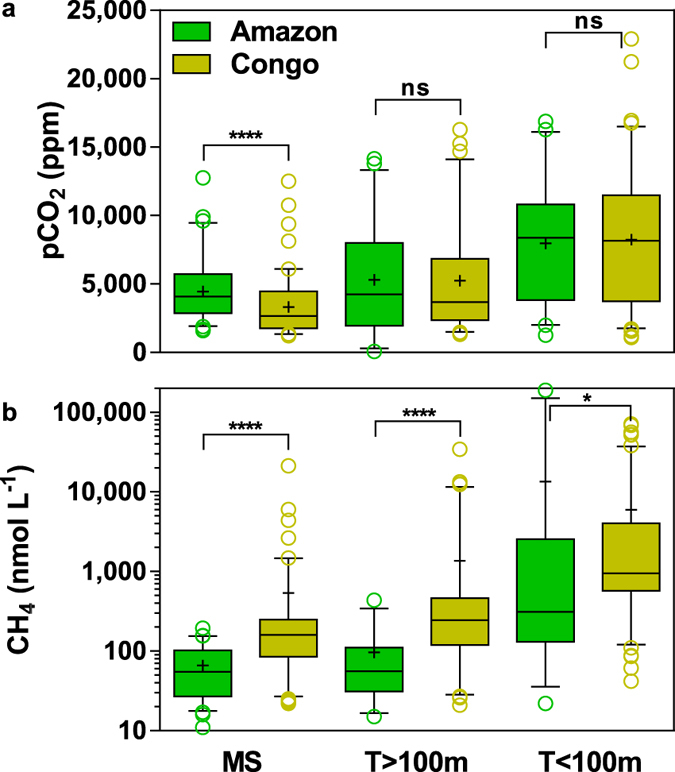
Box and whisker plots of pCO2 (a) and CH4 (b) in the Amazon and Congo.The box spans the interquartile range (25–75 percentiles), whiskers correspond to 5–95 percentiles, horizontal bar to median, cross to average, and circles to outliers. Differences were tested with a Mann Whitney test at 0.05 confidence interval level, where **** corresponds to p < 0.0001, * to p = 0.0278, and ns to not significant. MS = mainstem. T > 100m = large tributaries. T < 100m = small tributaries.